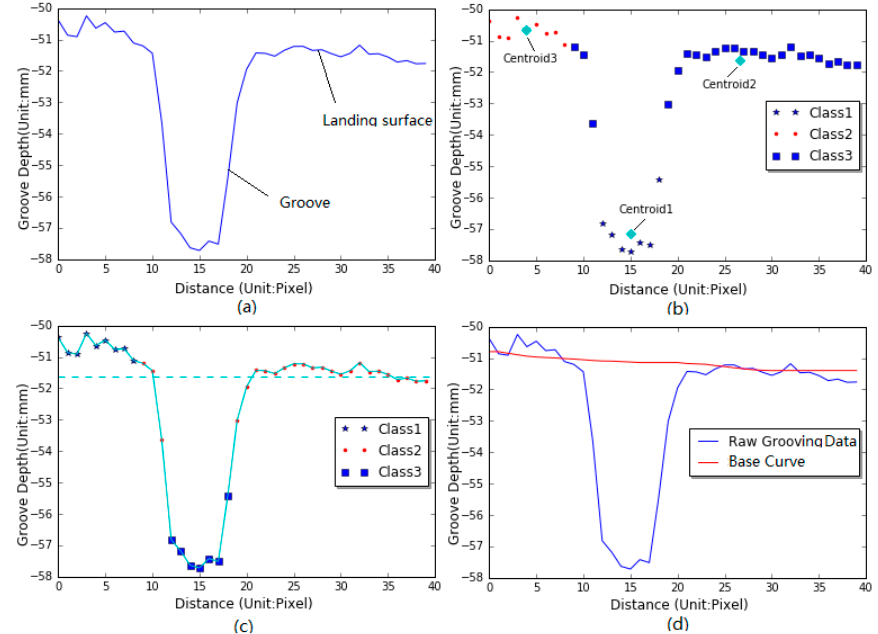
Figure 3. Development and implementation of K-means clustering based filter ( a ) grooving data; ( b ) three clusters; ( c ) data above dashed line used for smoothing; ( d ) the smoothing effect of grooving data.